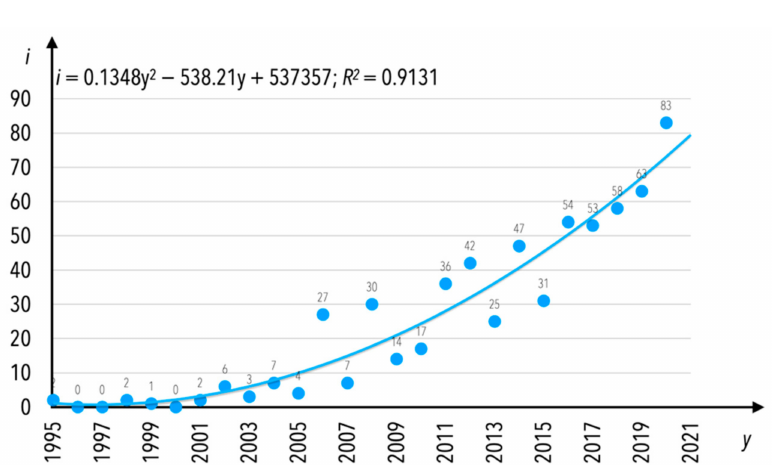
Figure 9. Number of publications ( i ) in the research area of track condition monitoring per year ( y ) for the internal keywords “condition